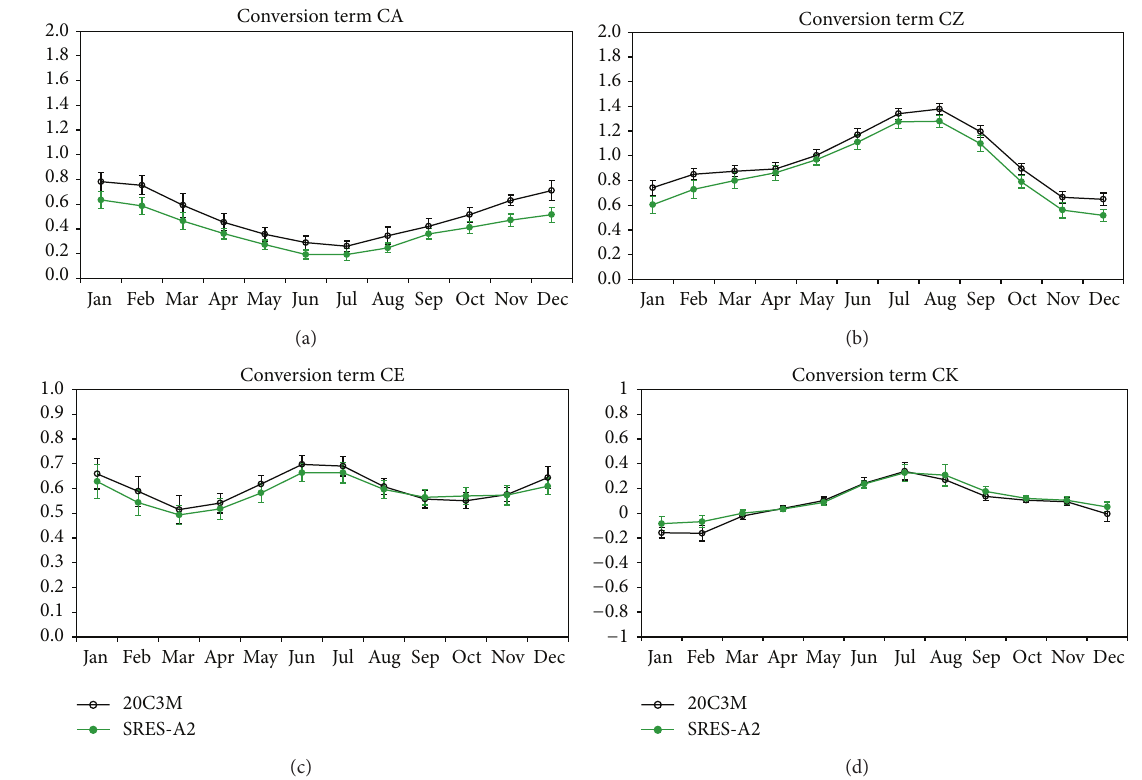
Figure 9: Mean SDLEC conversion terms for the period 1979–1999 (20C3M) and 2079–2099 (SRES-A2). Results for 20C3M and SREAS2 are based on an average from CGCMs results (CRNM, CGCM, and ECHAM5). Error bars indicate 95% confidence intervals about the mean. Units are Wm −2